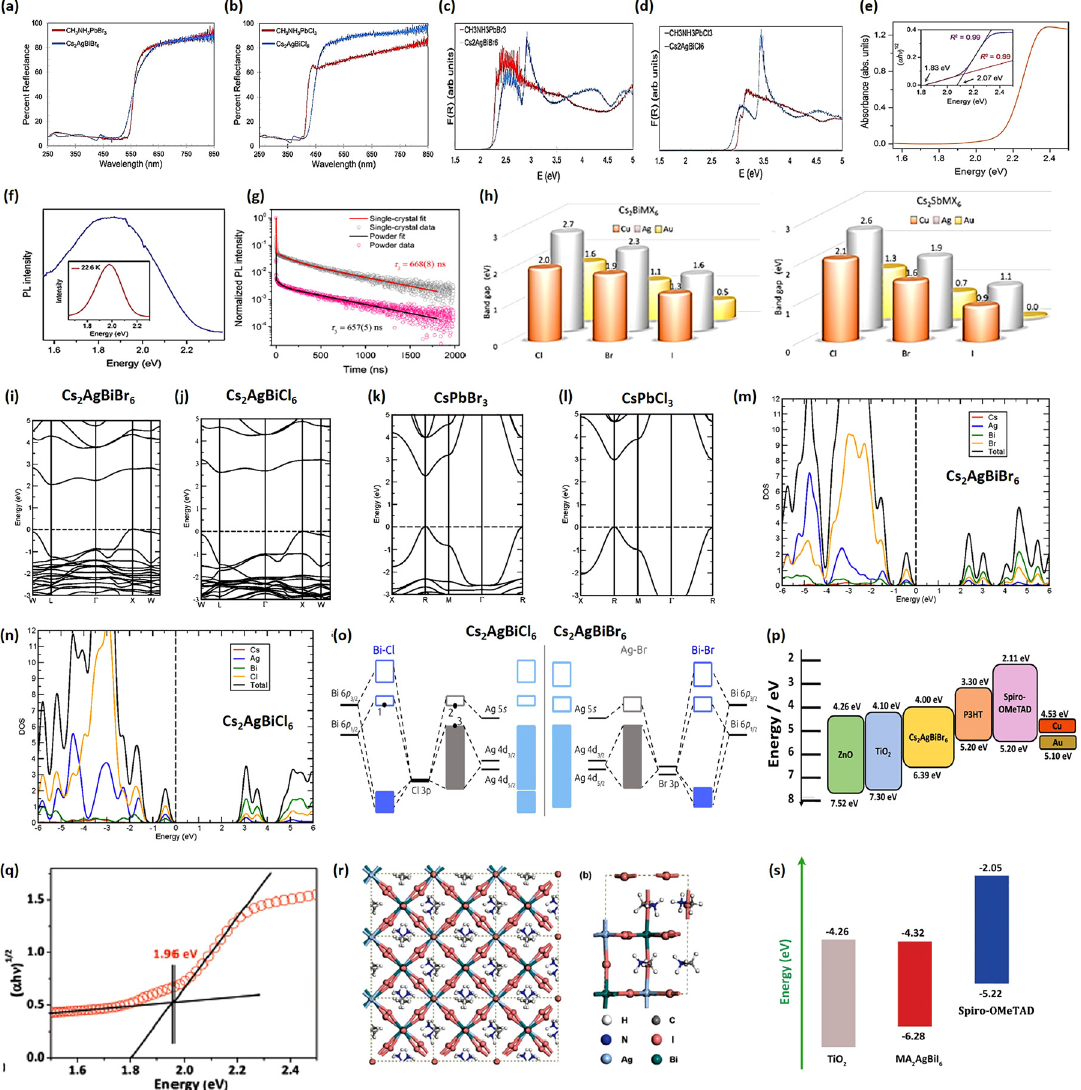
Figure 1: Diffuse reflectance spectra for (a) Cs 2 AgBiBr 6 (blue) and CH 3 NH 3 PbBr 3 (red) and (b) Cs 2 AgBiCl 6 (blue) and CH 3 NH 3 PbCl 3 (red)